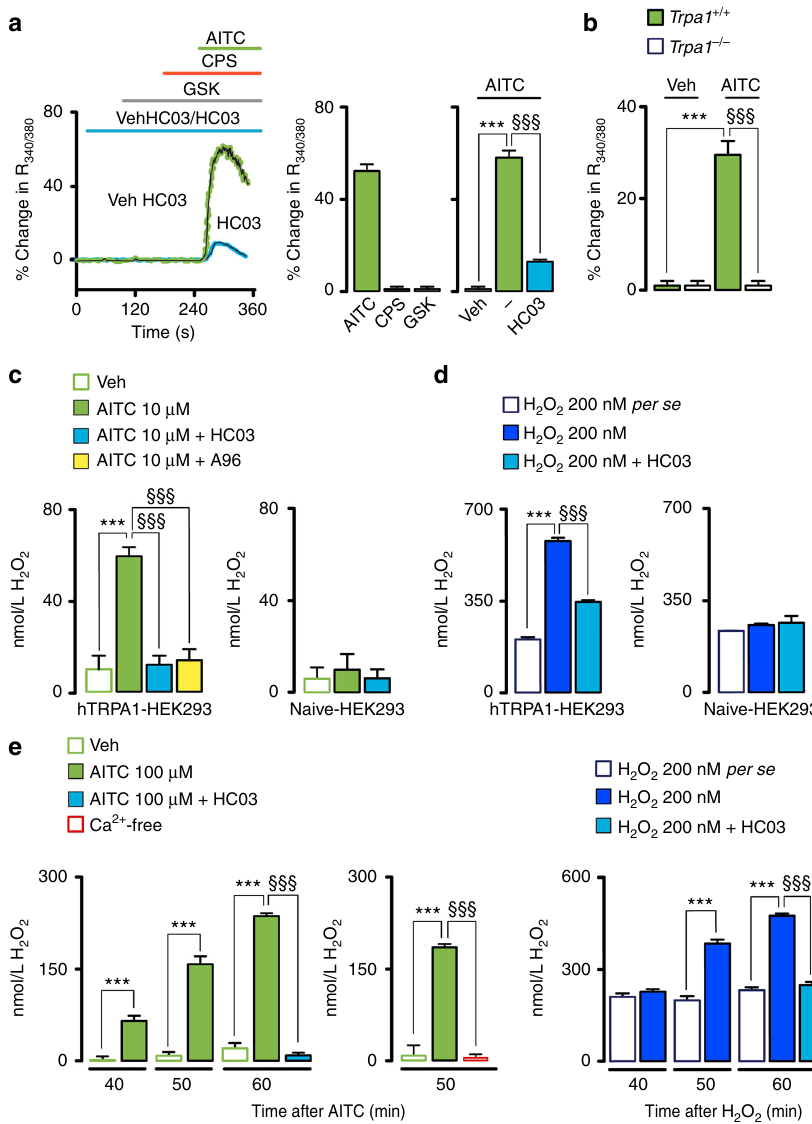
Fig. 4 Schwann cells expressing TRPA1 release H 2 O 2 . a Ca 2+ responses to AITC (1 mM) in cultured Schwann cells with HC-030031 (HC03, 30 µ M) or its vehicle (veh, 0.3% DMSO) and to TRPV1- (capsaicin, CPS, 0.5 µ M) or TRPV4- (GSK1016790A, GSK, 50 nM) agonists ( n = 25 cells from 3 independent experiments, *** P < 0.001 AITC vs. veh; §§§ P < 0.001 HC03 vs. AITC; one-way ANOVA followed by Bonferroni post hoc analyses). b AITC (1 mM)-evoked calcium response in Schwann cells from Trpa1 +/+ , but not from Trpa1 − / − mice ( n = 25 cells from 3 independent experiments, *** P < 0.001 Trpa1 +/+ AITC vs. Trpa1 +/+ veh; §§§ P < 0.001 Trpa1 − / − AITC vs. Trpa1 +/+ AITC; one-way ANOVA followed by Bonferroni post hoc analyses). c , d H HEK293 or untransfected (naïve-HEK293) cells induced by AITC (10 µ M) or H 2 O 2 (200 nM) and effect of HC03 (30 µ M), A-967079 (A96, 30 µ M) or respective vehicles (veh, 0.3% DMSO) ( n = 8 replicates from three independent experiments, *** P < 0.001 AITC, H 2 O 2 vs. veh; §§§ P < 0.001 AITC, H 2 O 2 + HC03/A96 vs. AITC, H 2 O 2 ; one-way ANOVA followed by Bonferroni post hoc analyses; H 2 O 2 200 nM per se represents the value of H 2 O 2 over the time, not in presence of cells). e H 2 O 2 release from cultured mouse Schwann cells evoked by AITC (100 µ M) or H 2 O 2 (200 nM) and effect of HC03 (30 µ M) and Ca 2+ -free medium (Ca 2+ -free) ( n = 8 replicates from three independent experiments, *** P < 0.001, veh-AITC/H 2 O 2 vs. AITC/H 2 O 2 ; §§§ P < 0.001 HC03 vs. AITC, H 2 O 2 ; one-way ANOVA followed by Bonferroni post hoc analyses; H 2 O 2 200 nM per se represents the value of H 2 O 2 without cells). Data are represented as mean ± (B6.129P- Trpa1 tm1Kykw/J ; Jackson Laboratories, Bar Harbor, ME, USA) 65 , wild type ( Trpv4 + / + ) and TRPV4-de fi cient ( Trpv4 − / − ) mice (25 – 30 g, 5 – 8 weeks), generated by heterozygotes on a C57BL/6 background 66 and TRPV1-de fi cient mice ( Trpv1 − / − ; B6.129 × 1- Trpv1 tm1Jul/J ) backcrossed with C57BL/6 mice ( Trpv1 + / + ) for at